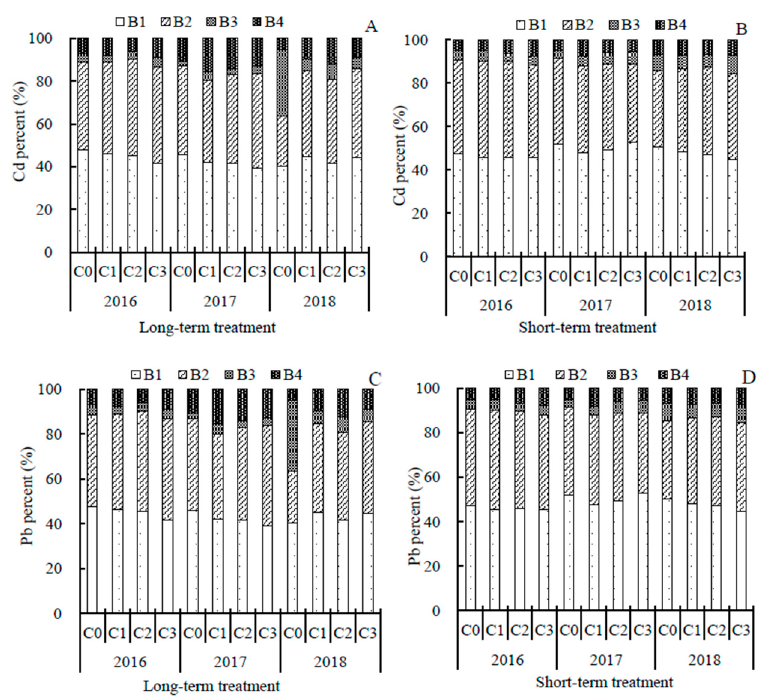
Figure 1. The effect of long- and short-term, increasing biochar application rates [0 (C0), 10 (C1), 20 (C2) and 40 (C3) t ha − 1 ] on Cd and Pb fractions based on a European Community Bureau of Reference (BCR) sequential extraction (( A ): Cd long-term; ( B ): Cd short-term; ( C ): Pb long-term; ( D ): Pb short-term). B1 = Exchangeable fraction; B2= Iron and manganese oxyhydroxides fraction; B3 = Organic fraction; B4 = Residual fraction.